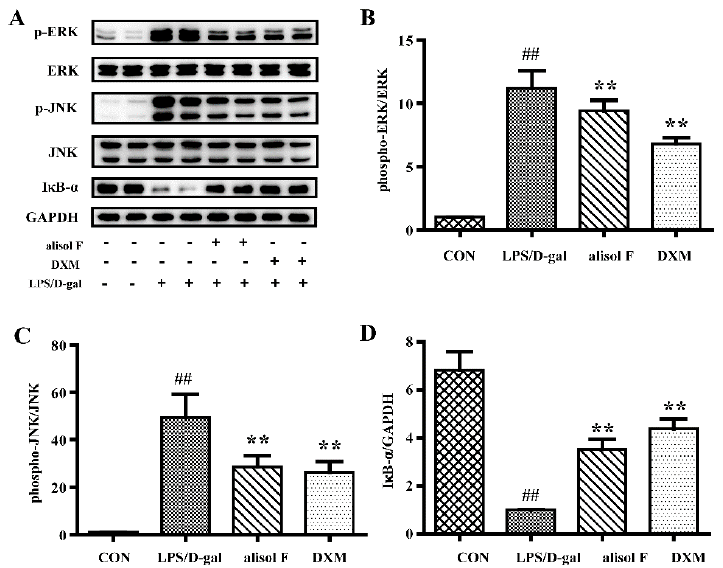
Figure 10. The effect of Alisol F on LPS/ D -gal-induced activation of MAPKs and NF- κ B signaling pathways in vivo. The mice were pretreated with Alisol F (20 mg/kg) and DXM (5 mg/kg) for three days, and induced with LPS/ D -gal (40 μ g/kg, 700 mg/kg). Liver samples were harvested at 5 h after LPS/ D -gal treatment. The protein expression of phospho-ERK phospho-JNK and I κ B- α were detected by Western blot. ( A ). Densitometry analysis of phospho-ERK ( B ), phospho-JNK ( C ) and I κ B- α ( D ) were shown. The data represent the means ± S.E. of three independent experiments. ( ## p < 0.001 vs. control group; * p < 0.05, ** p < 0.001 vs. LPS/ D -gal group).